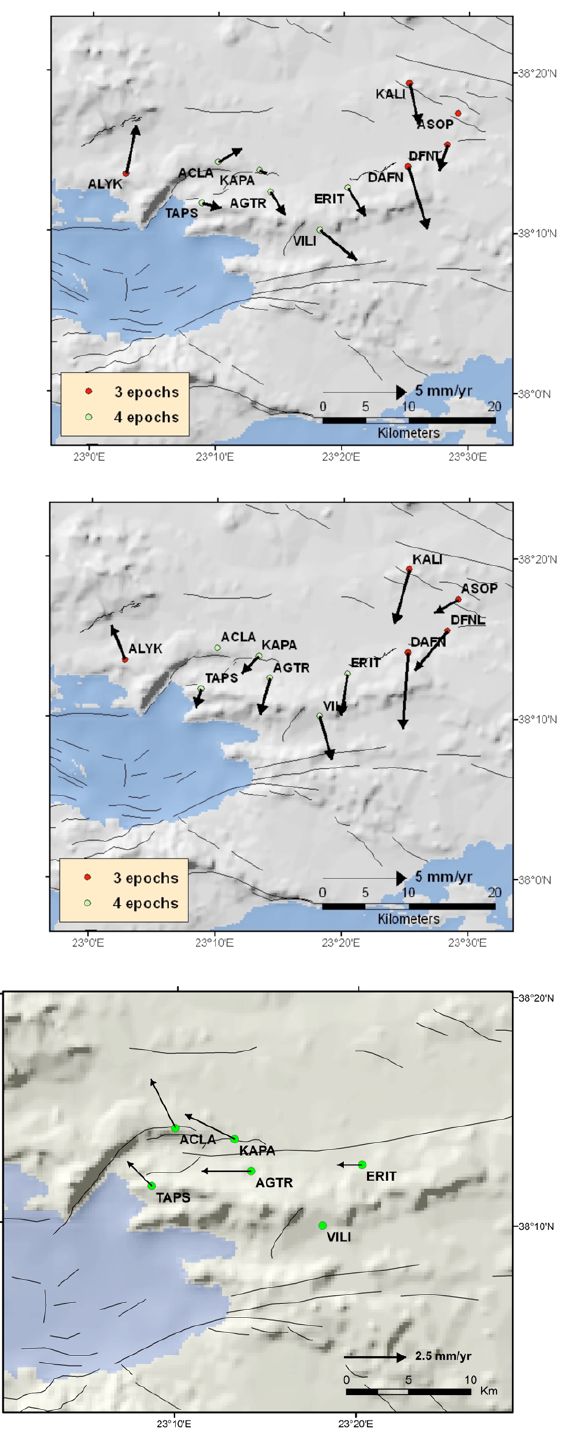
Figure 6 (top to bottom). Horizontal velocity vectors of KAPNET stations with respect to fixed ASOP (top) fixed ACLA (middle) and fixed VILI (bottom). Grey lines are active faults [Ganas et al. 2013b].